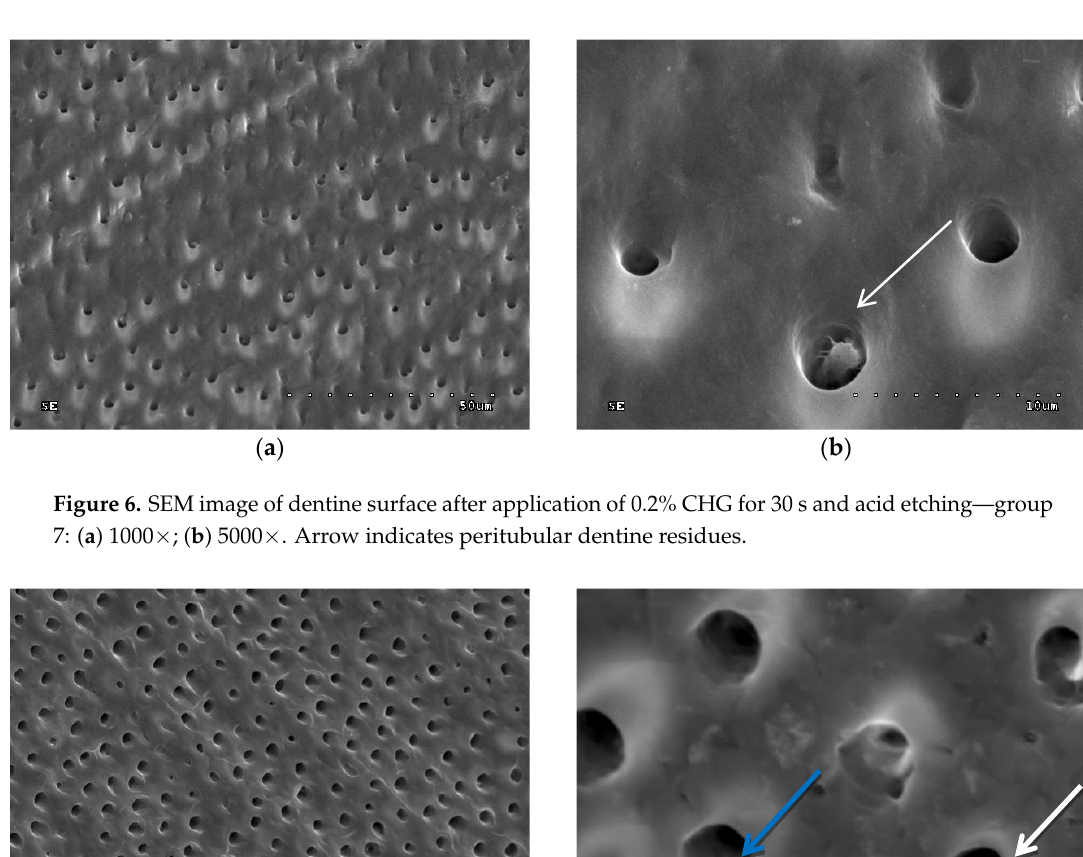
Figure 5. SEM image of dentine surface after application of 2.0% CHG for 30 s and acid etching—group 9: ( a ) 1000×; ( b ) 5000×.